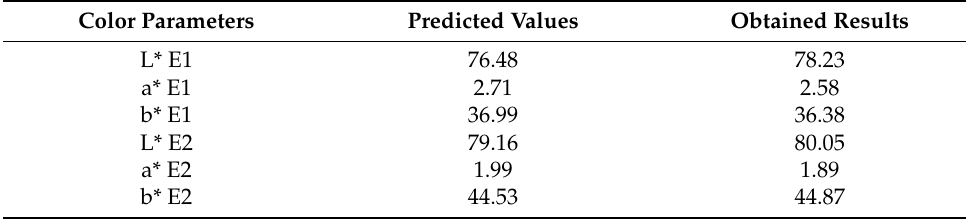
Table 8. Validation of optimal color parameters obtained by